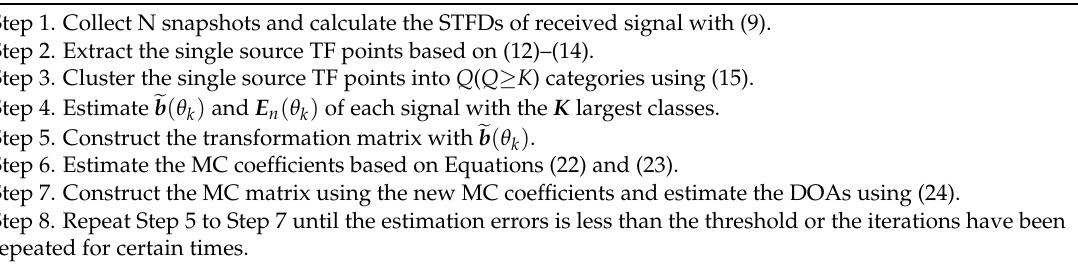
Table 1. Algorithm for estimation of DOA and direction-dependent MC based on